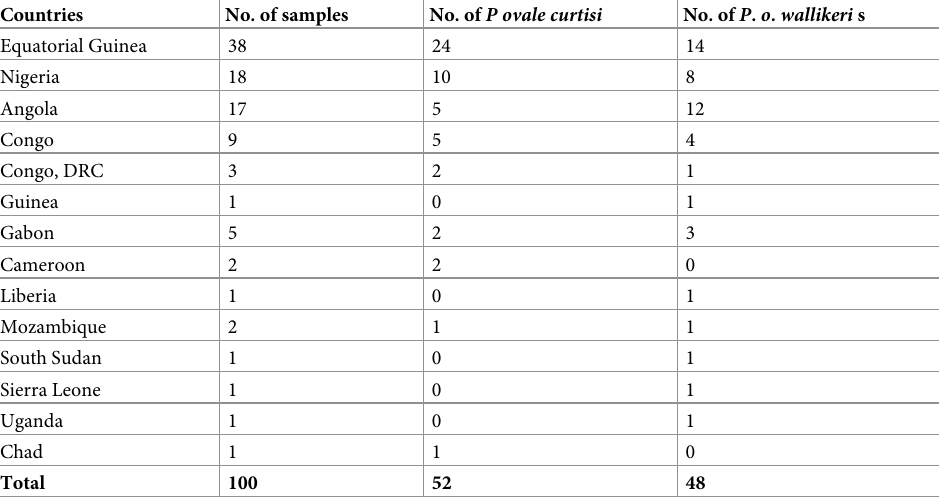
Table 1. Origins the of P . ovale infection acquired in Africa.